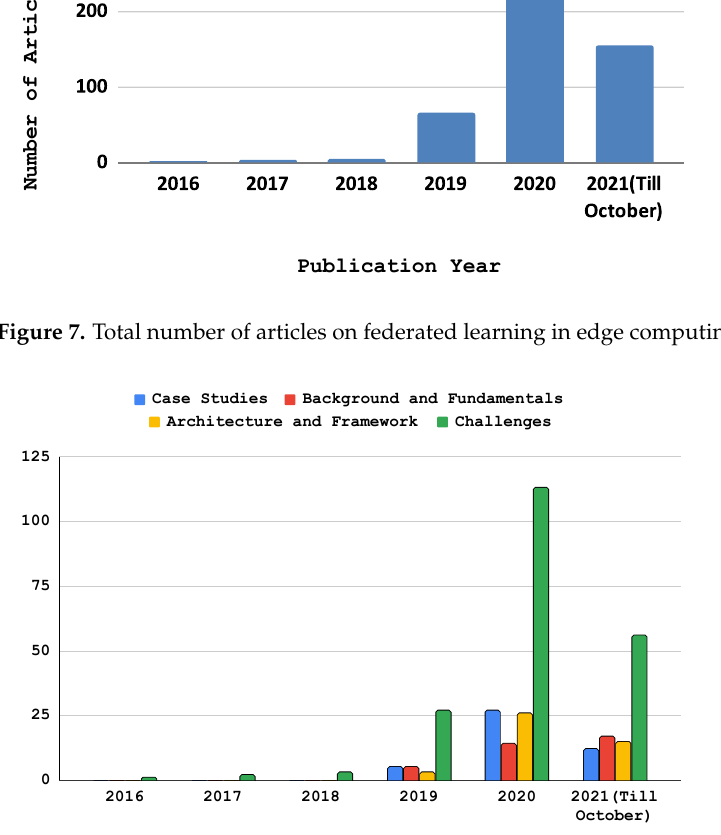
Figure 8. Total number of publications per year in the subject